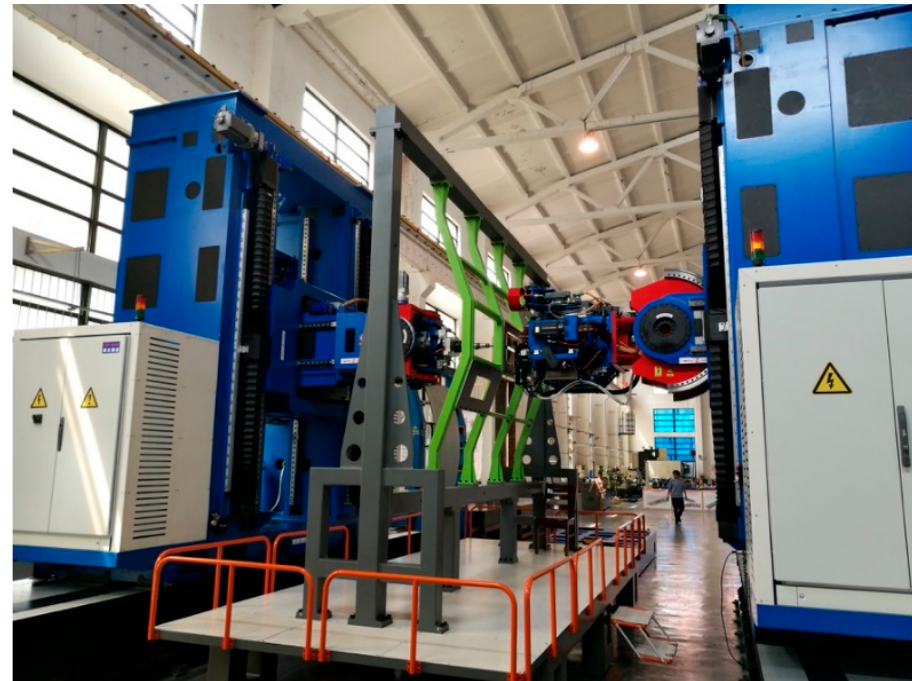
8 of 22 Figure 6. Residual circumferential stress around rivet and hole (unit: MPa). 2.3. Riveting Test Verification of Basic Pressure Riveting Model On the basis of finite element simulation, the riveting test of the single-riveted lap joint was carried out. The designed and manufactured riveted test piece is shown in Fig- ure 7. The connecting piece is composed of two 7050 aluminum alloy plates and a 100° small countersunk head 2A01 rivet. The dimension and structure are consistent with the finite element model. Figure 7. Riveting test piece. The pressure riveting process was completed by the automatic drilling and riveting machine. The automatic drilling and riveting machine was controlled to complete the hole making, countersinking and pressure riveting, and finally the test piece after the riveting was taken off. Figure 8 shows the test process of the automatic drilling and riveting ma-